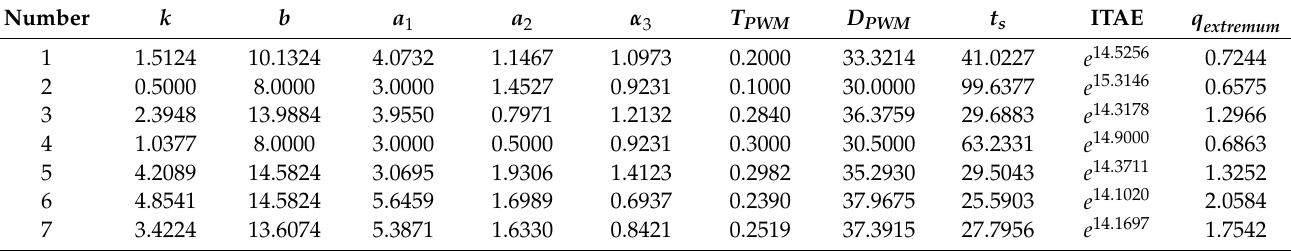
Table 5. Generation of pareto optimal solution